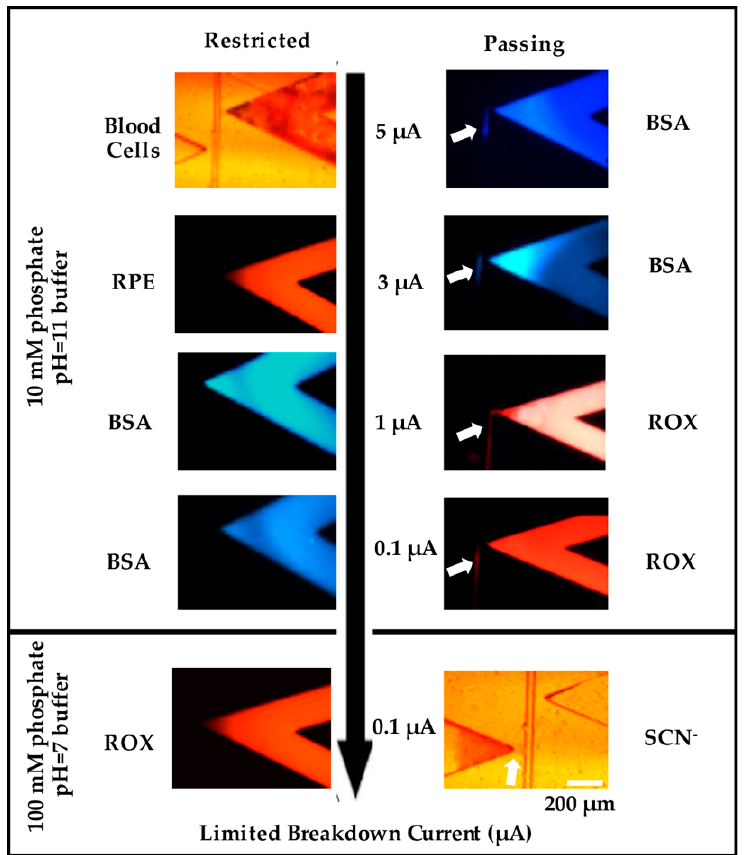
Figure 2. Screen shots showing the transport (right column) and restriction (left column) of different molecules through nanochannels created under different conditions. The top row shows the restriction of Blood Cells (left) and transport of BSA (blue, right); the second row shows the restriction of PDMS (red, left) and the transport of BSA (right); the third row shows the transport of ROX (right, Red) and restriction of BSA (left); the fourth row shows the restriction of BSA (left) and transport of ROX (right); the fifth row shows the restriction of ROX (left) and transport of thiocyanate (left). The first four rows used nanochannels created using a breakdown electrolyte of 10 mM phosphate buffer, pH = 11, and different terminating currents (5, 3, 1, and 0.1 µ A), while the fifth row used a breakdown electrolyte of 100 mM phosphate buffer, pH = 7, and a terminating current of 0.1 µ A. Images on the right show permeability (arrow), while those on the left show blocked transport. Scale Bar = 200 µ